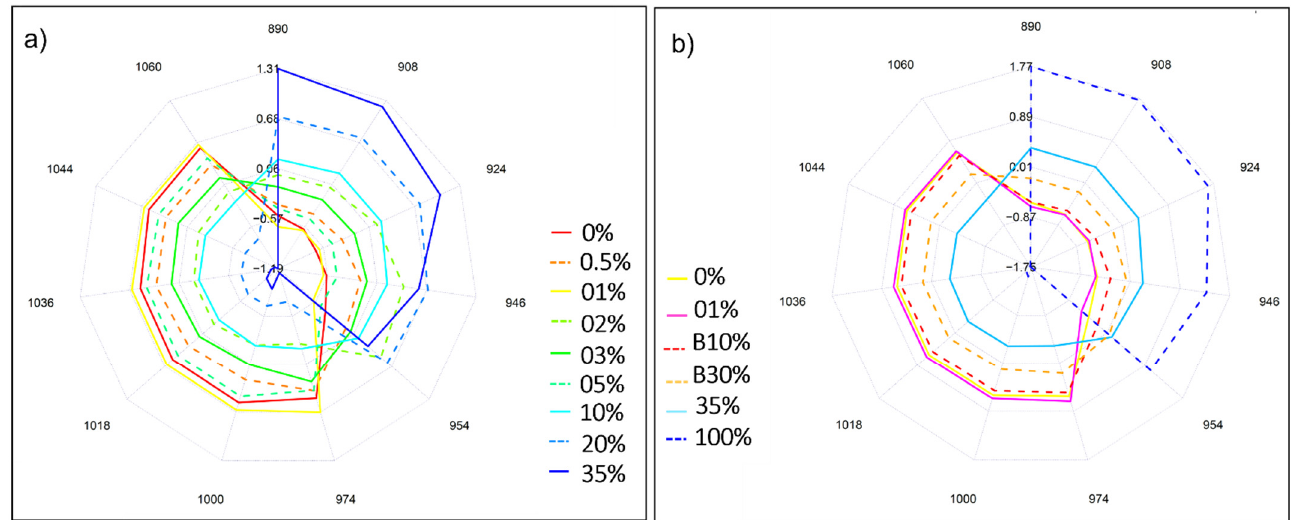
Figure 9. a ) Aquagrams of aqueous solutions of Robusta-Arabica blends in the concentration range of 0.5–35% and pure Arabica (0%) in the second overtone region; b ) Aquagram of the dataset com- prising pure Arabica (0%), pure Robusta (100%), Robusta-Arabica blends (01% and 35%) and marketed blends (B10% and B30%) .